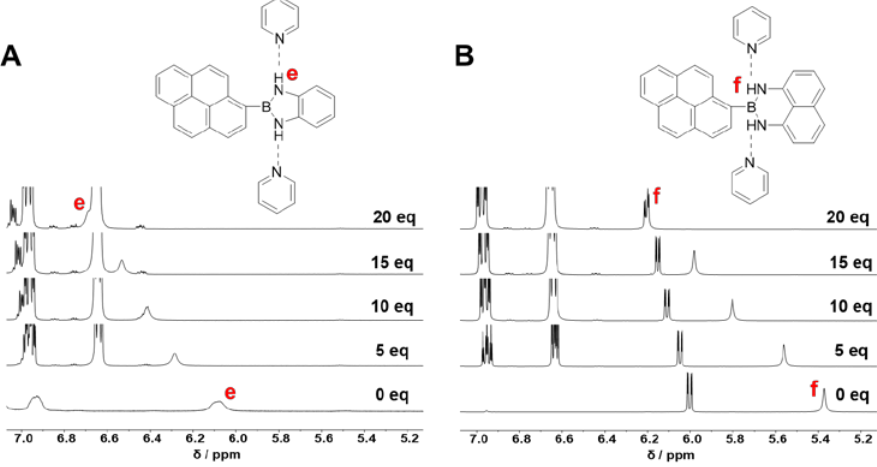
Figure 2. 1 H-NMR titration of ( A ) Py-NBN-Ph (c 0 = 1.572 × 10 −3 M) and ( B ) Py-NBN-Naphth (c 0 = 8.152 × 10 −3 M) with pyridine in C 6 D 6 at 298